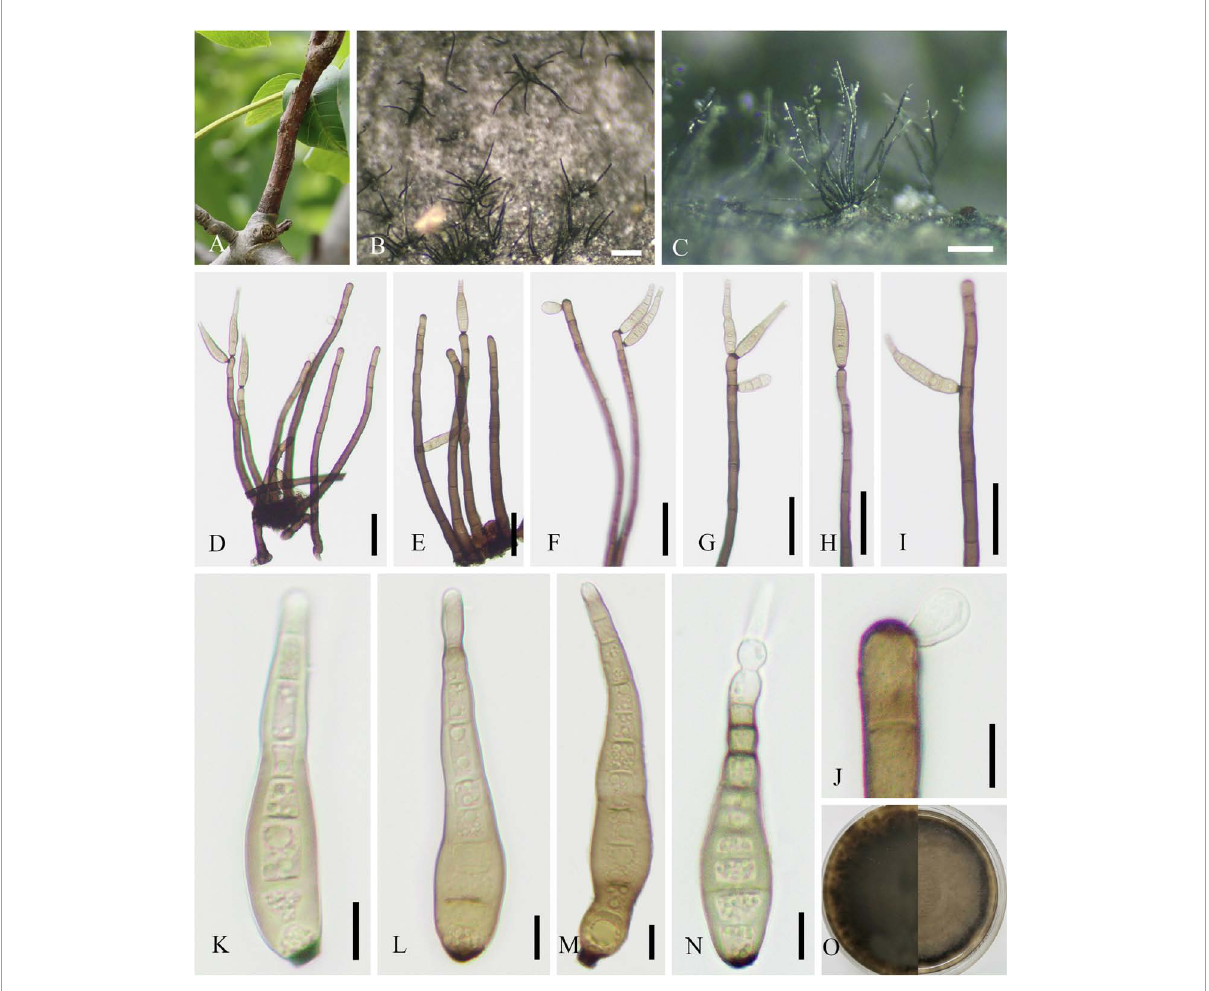
FIGURE4 Helminthosporium velutinum (SICAU 22-0099). (A) Symptoms of dead twig observed on host. (B) Colonies in face view. (C) Conidiophores with apical and lateral conidia in side view. (D–J) Conidiophores with apical and lateral conidia and pores. (K–M) Conidia. (N) Germinating conidium. (O) Colony on PDA for 15 days. Scale bars: (B,C) 200 um, (D–I) 50 um, and (J–N) 10 um.